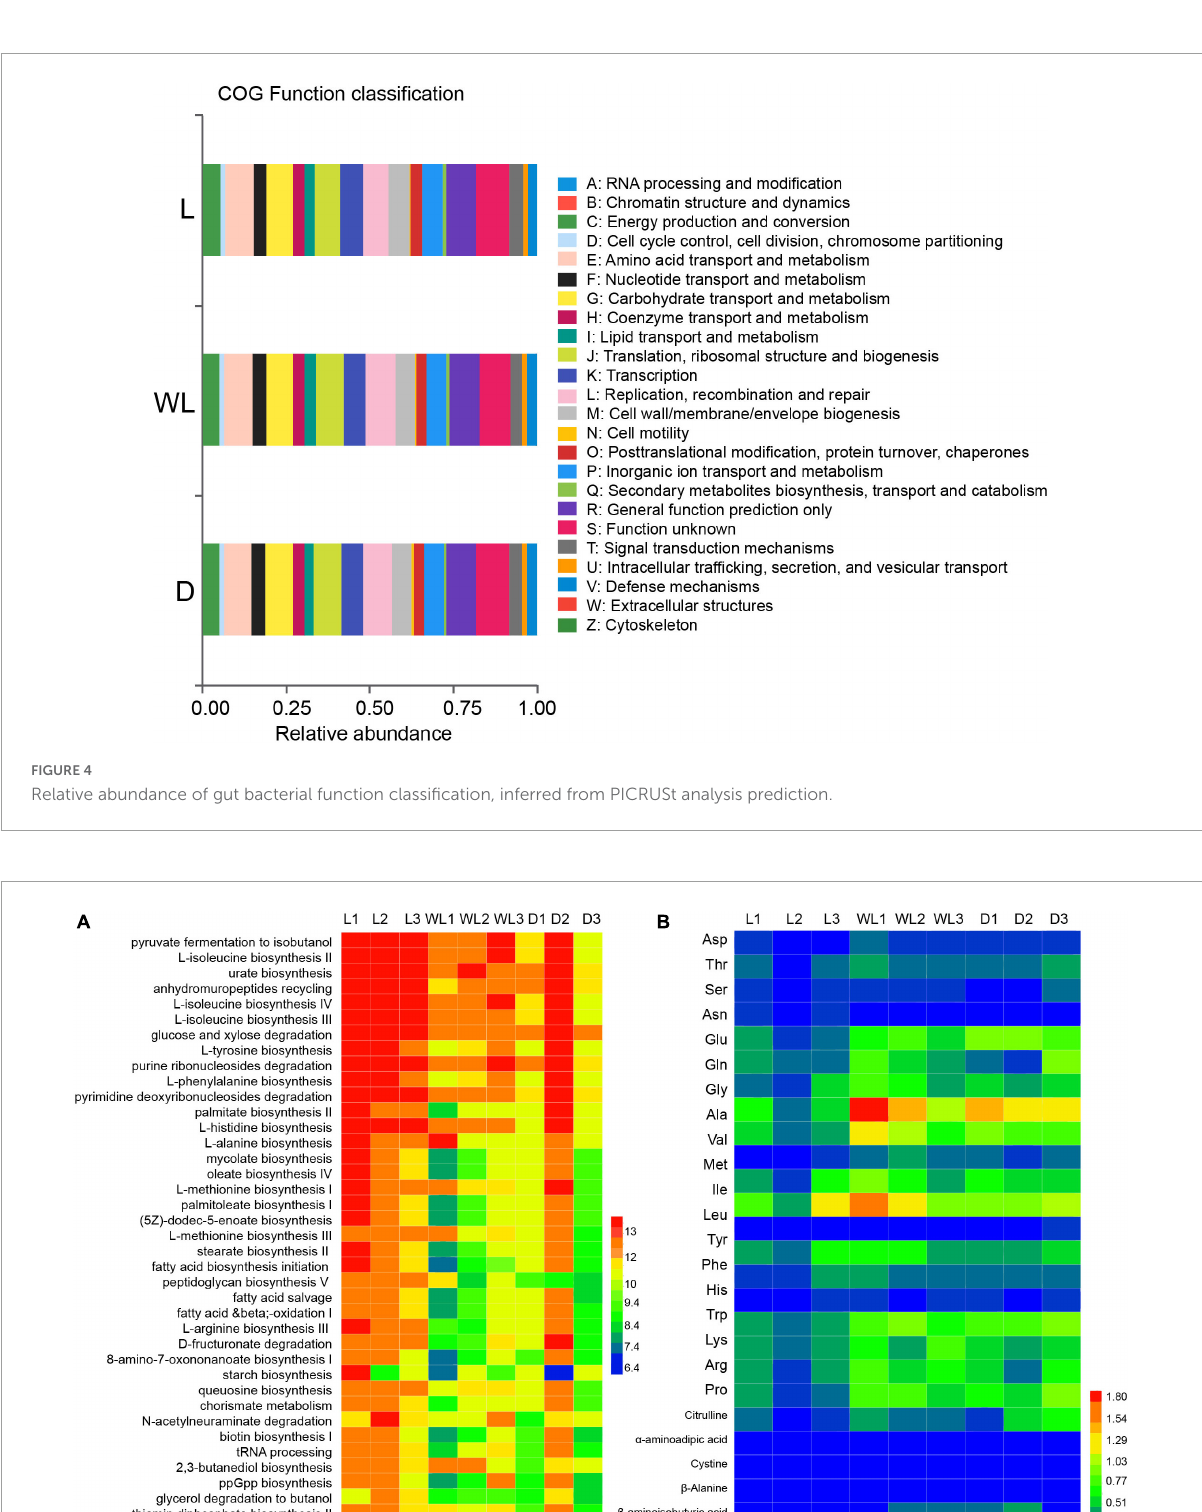
FIGURE5 Abundance of metabolism pathway (A) and titer of amino acids (B) , the three letter codes represent the different amino acids, following the general amino acid code list, and the color scales indicate the abundances of metabolism pathways and amino acids.